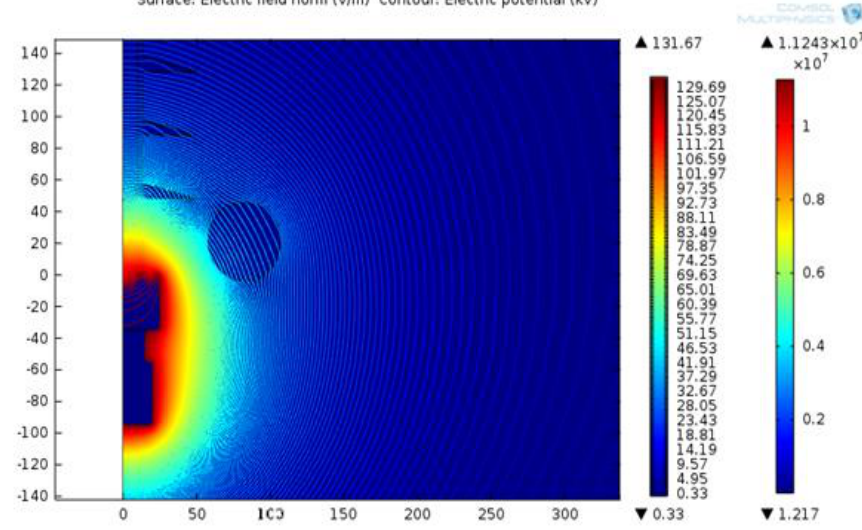
Figure 15. Optimal dimensions and minimum electric field.